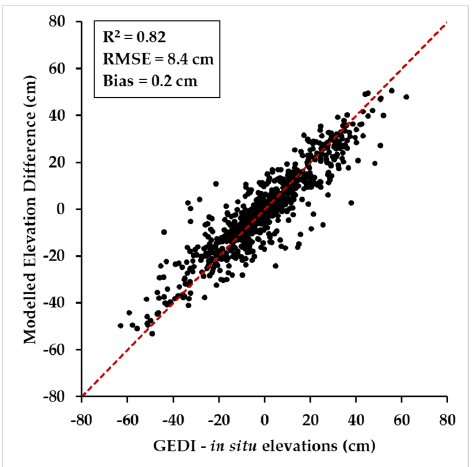
Figure 9. Comparison between the modeled elevation difference as a function of instrumental and environmental factors and the obtained elevation difference between GEDI and in-situ elevations.